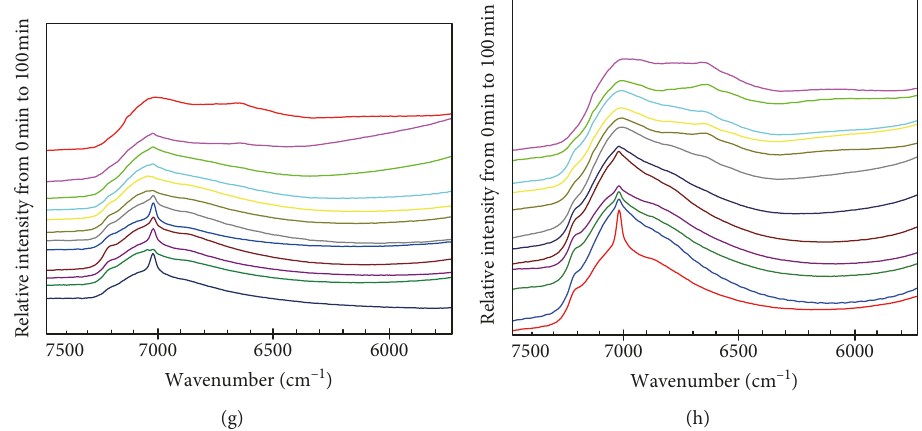
1 region. (a) S1 (hydrozincite and −